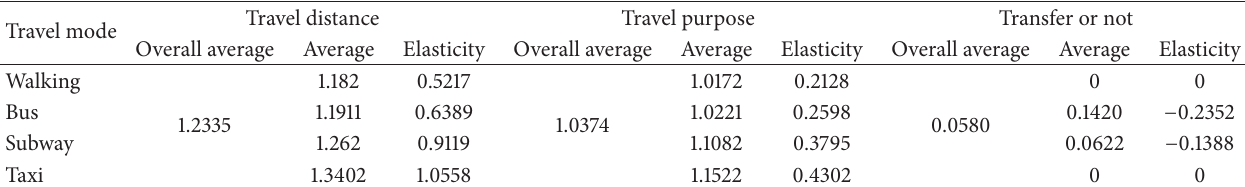
Table 6: Average value and elasticity value of travel